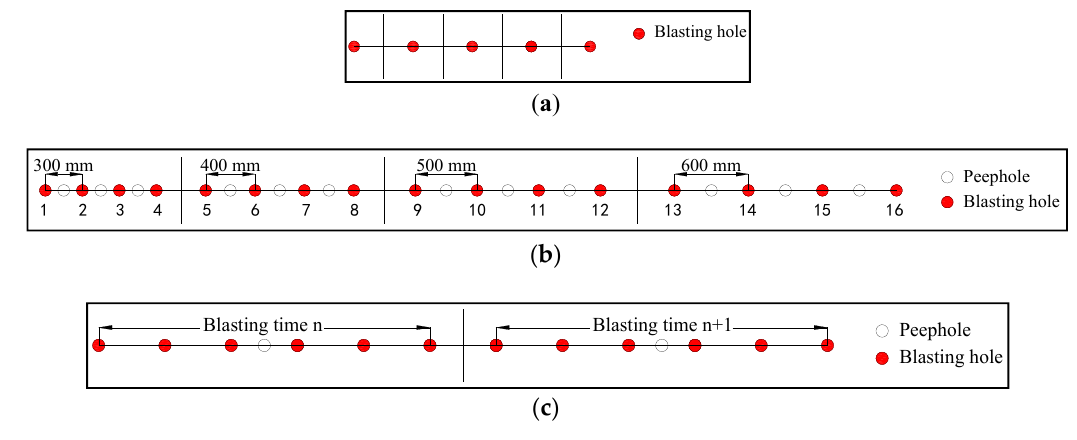
Figure 6. Blasthole layout of blasting test: ( a ) single hole blasting test; ( b ) interval hole blasting test; ( c ) continuous hole blasting test.